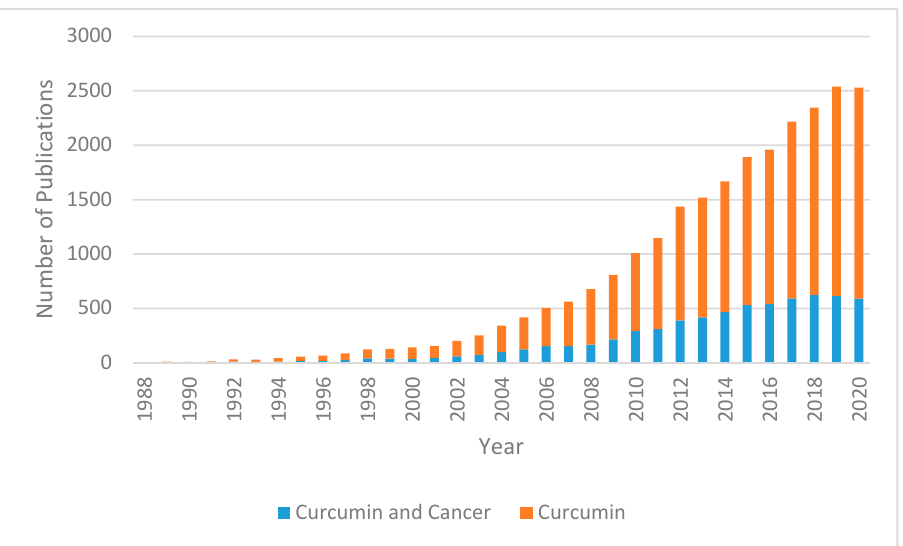
Figure 1. Number of publications since 1988 (sourced from PubMed Database). The blue portion of the bar represents proportion of results returned with search terms “curcumin” and “cancer” while the orange portion represents the total number of studies returned with the search term “curcumin”.